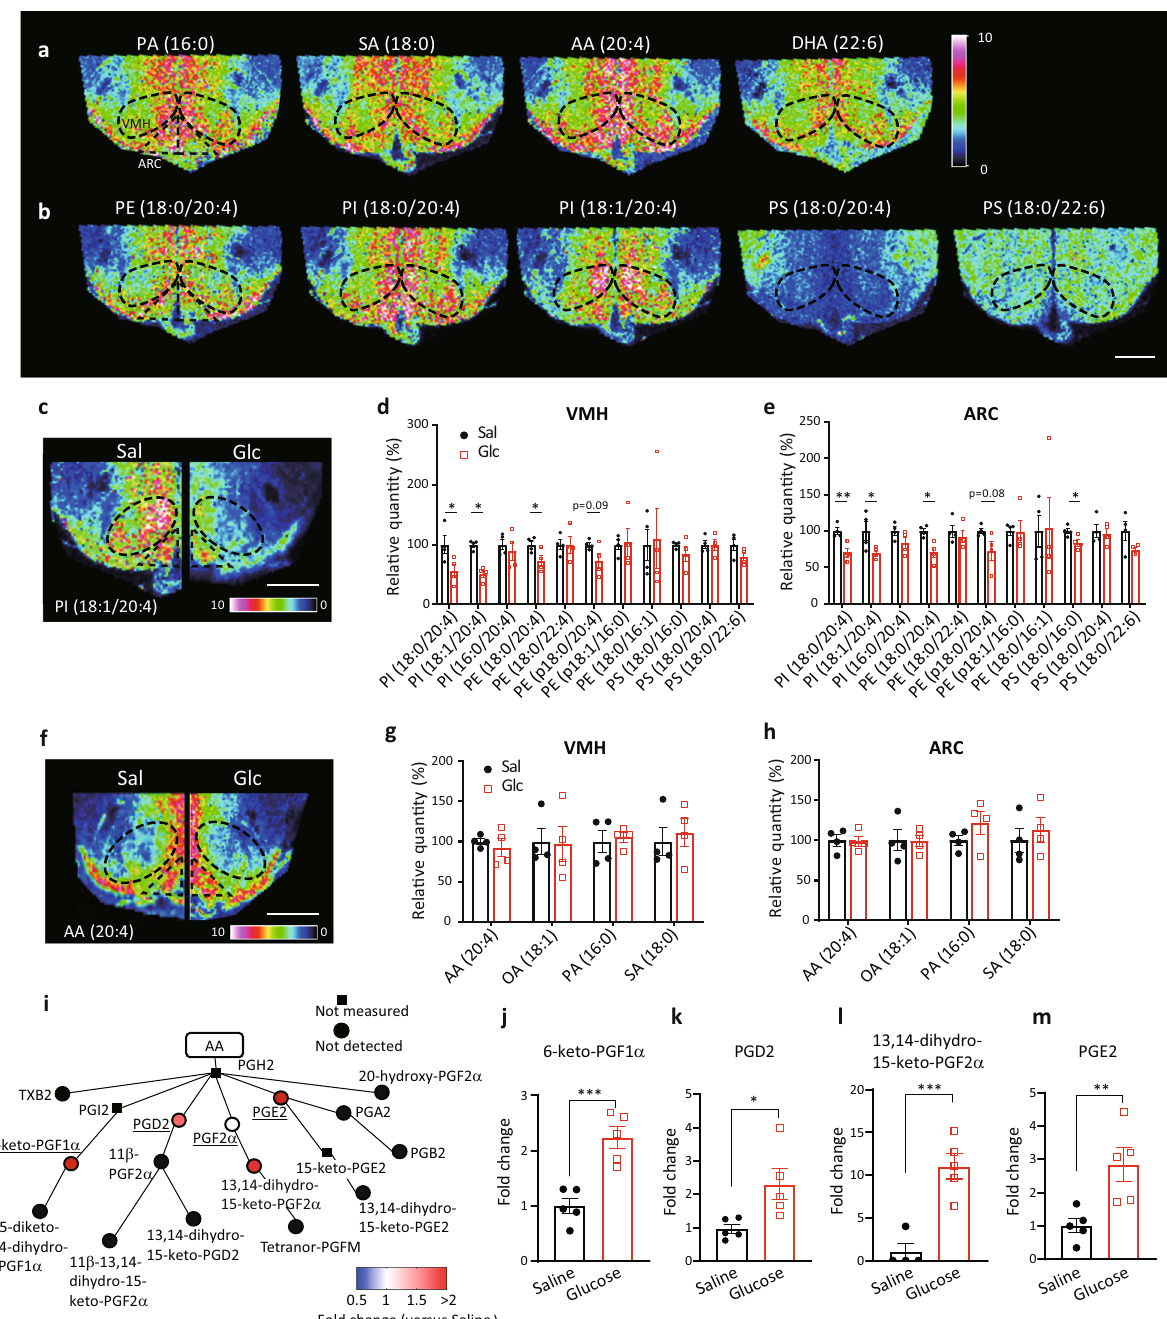
Fig. 1 Hyperglycemia increases prostaglandin production derived from phospholipids. a , b Representative results of imaging mass spectrometry (IMS) showing distributions of hypothalamic fatty acids ( a ) and phospholipids ( b ) from untreated RCD-fed mice. The dashed black line shows the position of the VMH. Scale bar: 500 μ m. c – h Distributions of phospholipids and fatty acids in the hypothalamus 30 min after injection of saline (Sal) or glucose (Glc; 2 g/ kg). c , f Representative results of IMS on hypothalamic phosphatidyl-inositol (PI; 18:1/20:4) ( c ) and arachidonic acid (AA) ( f ) from mice i.p. injected with saline (left half) or glucose (right half). Scale bar: 500 μ m. d , e Relative intensities of phospholipids in the VMH ( d ) and ARC ( e ) after injection with saline ( n = 4) or glucose ( n = 4). (two-tailed t test for each molecule, VMH: p = 0.0268 in PI (18:0/20:4), p = 0.0005 in PI (18:1/20:4), and p = 0.0491 in PE (18:0/20:4); ARC: p = 0.0073 in PI (18:0/20:4), p = 0.0347 in PI (18:1/20:4), p = 0.0106 in PE (18:0/20:4), and p = 0.0331 in PS(18:0/16:0), Glc vs Sal g , h Relative intensities of fatty acids in the VMH ( g ) and ARC ( h ) after injection with saline ( n = 4) or glucose ( n = 4). i – m LC-MS results showing the effects of glucose injection on AA metabolites in the whole hypothalamus. i Relative amounts of hypothalamic prostaglandins mediated by cyclooxygenase. Major prostaglandins were underlined. j 6-keto-PGF1 α , k PGD2, l 13,14-dihydro-15-keto-PGF2 α and m PGE2 were increased by glucose injection (two-tailed t test, p = 0.0009 in j , p = 0.0244 in k , p = 0.0011 in l , p = 0.0099 in m , n = 5/each, Glc vs Sal). d – h and j – m represent the mean ± SEM; * p < 0.05; ** p < 0.01; *** p < 0.001. i represents the mean fold change in color. PA palmitic acid, SA stearic acid, AA arachidonic acid, DHA docosahexaenoic acid, PE phosphatidyl-ethanolamine, PI phosphatidyl-inositol, PS phosphatidyl-serine.